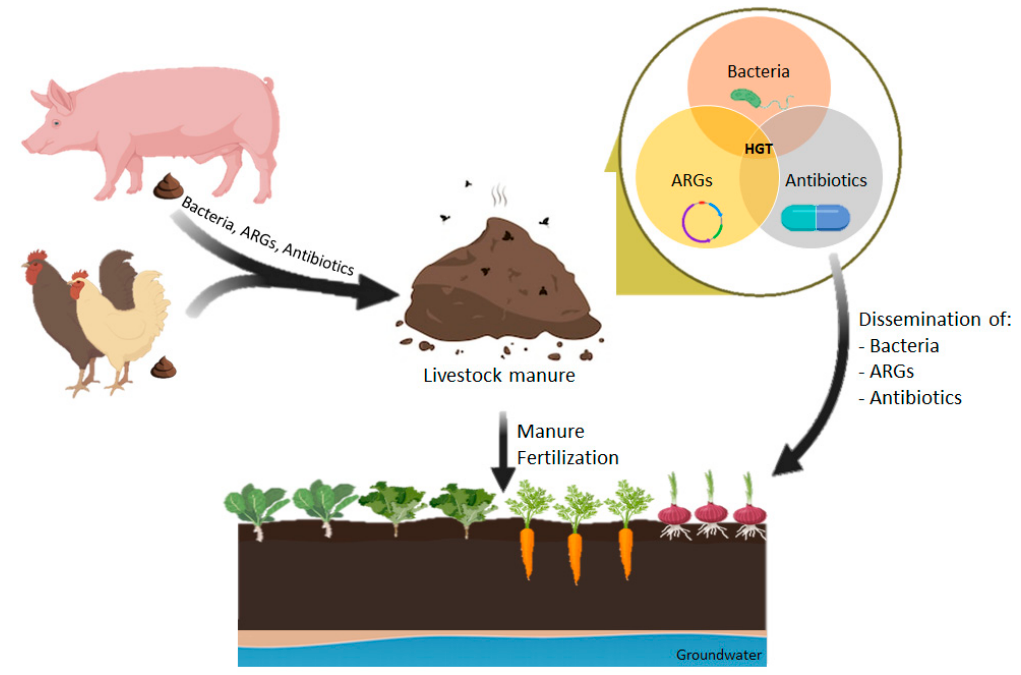
Figure 1. Figure 1. Dissemination of antimicrobial resistance associated with manure application in agricultural soils.